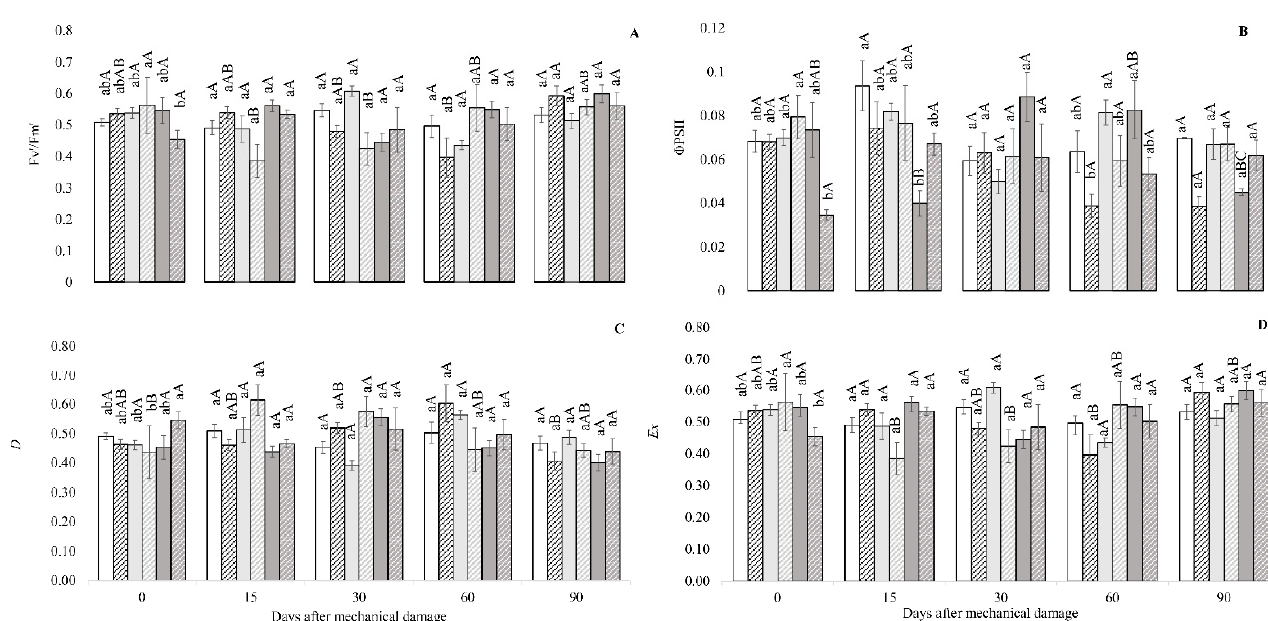
Figure 2. ( A ) Potential quantum efficiency of open PSII center (Fv’/Fm’) p < 0.012; ( B ) Effective quantum efficiency of PSII photochemistry ( Φ PSII) p < 0.003; ( C ) Light fraction absorbed by PSII antenna that is dissipated as heat ( D ) p < 0.012; ( D ) Energy fraction not dissipated in the antenna that cannot be used for photochemistry stage (Ex) p < 0.012, in Annona emarginata plants submitted to the treatments: 0 mM Ca 2+ without mechanical damage (intact), 0 mM Ca 2+ with mechanical damage (w/MD), 2 mM Ca 2+ intact, 2 mM Ca 2+ w/MD, 4 mM Ca 2+ intact, and 4 mM Ca 2+ w/MD, at evaluation times: 0 (30 min) 15, 30, 60, and 90 days. Values corresponding to means ± SE ( n = 4). Lowercase letters indicate differences between treatments within each evaluation time and uppercase indicate differences between each treatment over evaluation time.